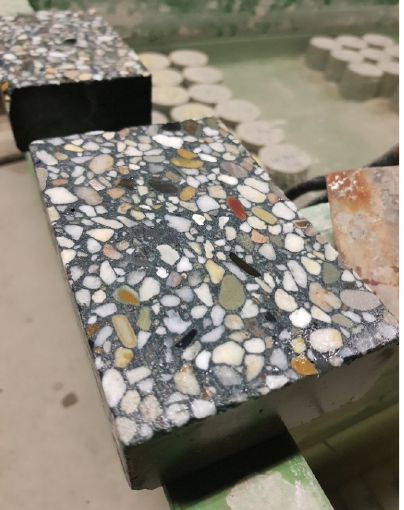
Figure 6. Concrete specimen with high packing den- sity of the coarse grain.